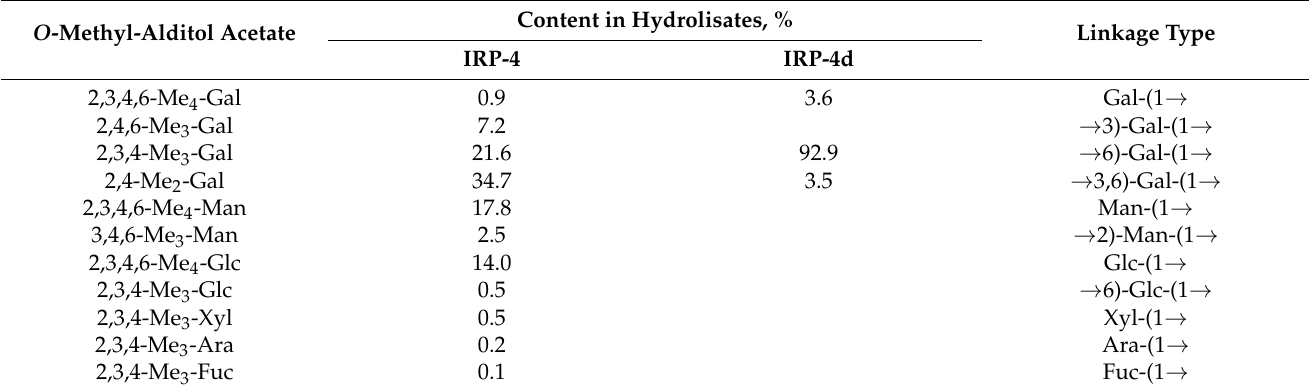
Table 3. Content of O -methyl-alditol acetates in hydrolysates of IRP-4 and IRP-4d